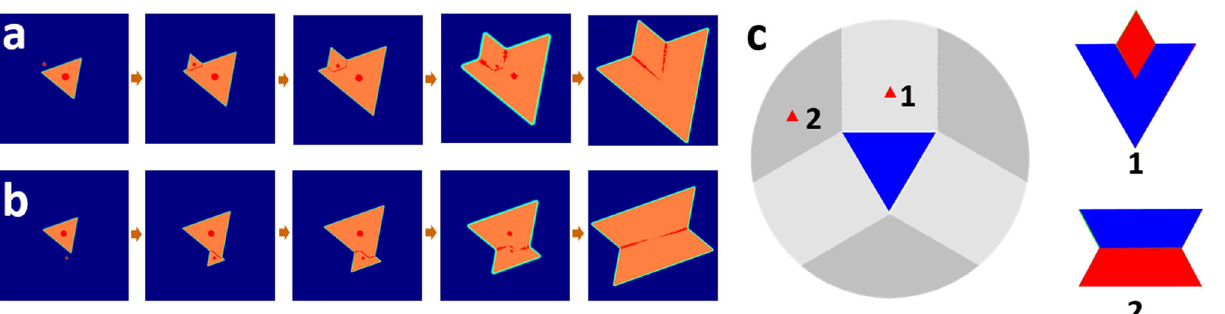
Fig. 2 Coalescence of two triangular grains with a misorientation angle of 60 o . a , b PFT simulations showing two coalescence processes between two triangular grains with a 60 o misorientation angle, respectively. Red dots represent the nucleation centers of the two triangular islands. The GBs in polycrystals are denoted by red lines. The fourth and fi fth panels in ( a , b ) are properly zoomed out for a better view. c Topography diagram for the coalescence of two triangular grains with a misorientation angle of 60 o . In the left panel, the blue triangle represents the fi rst grain, areas colored in a light gray and dark gray show where the second island nucleates. Shapes 1 and 2 in the right panel show the shapes of the polycrystal formed by the coalescence of the fi rst island and the second one that is nucleated in the light gray area and in the dark gray area,